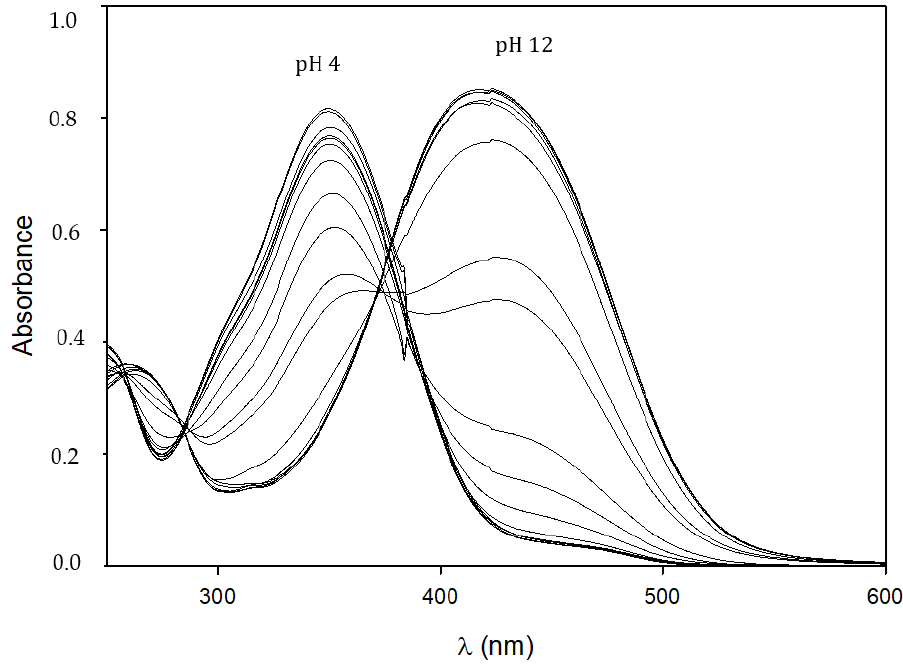
Figure 5. UV–Vis spectra of 7 at 25 °C in an aqueous solution (L = 50 μ M) with increasing pH. Many equilibria occur as pointed out by the woven structure close to the isosbestic point, particularly dissociation reactions. Elaboration of the data allows estimating the overall protonation constants (log β MLH ) and pK a values for all the compounds, as reported in Table